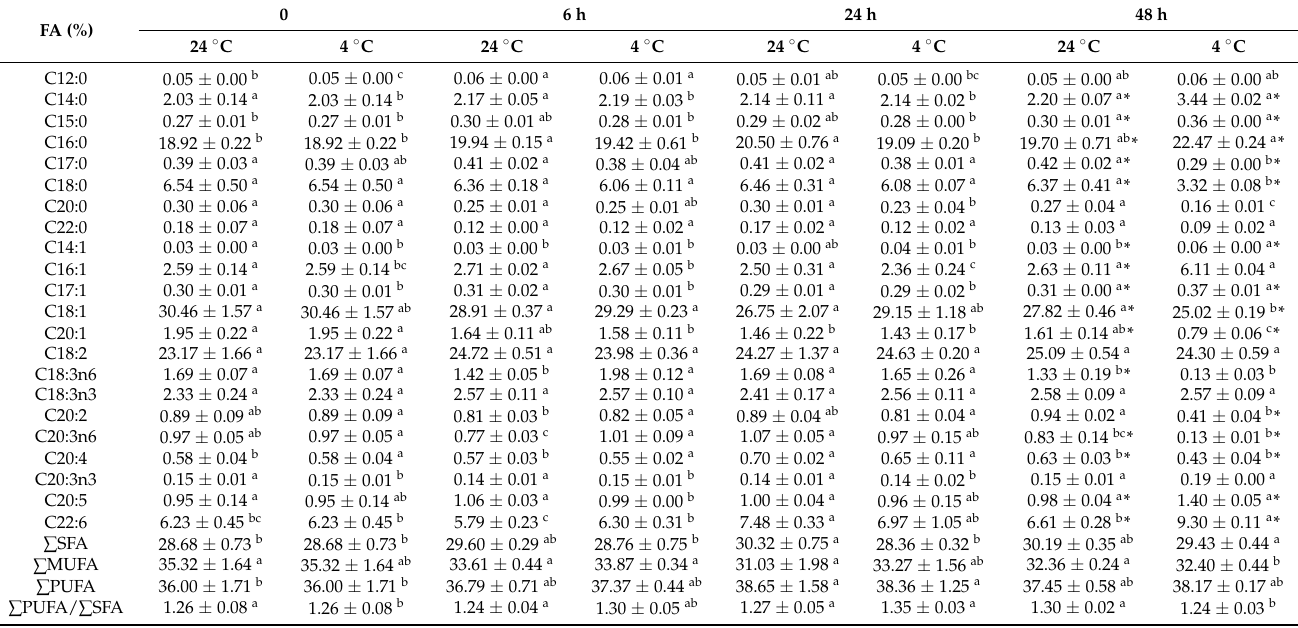
Table 4. Fatty acid (FA) content (%) of American shad as storage progressed at 24 ◦ C (unrefrigerated) and 4 ◦ C